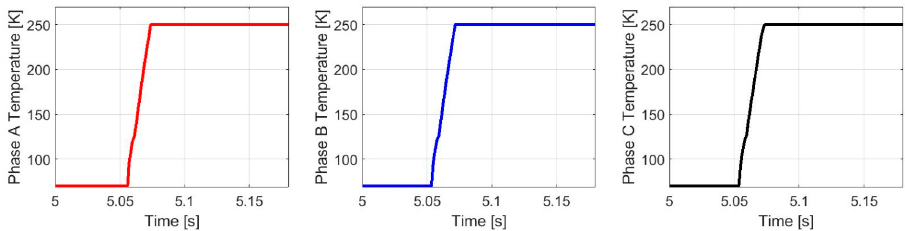
Figure 10. Temperature for phases A, B, and C for 3-Phase-to-ground fault at 50% of cable’s length.